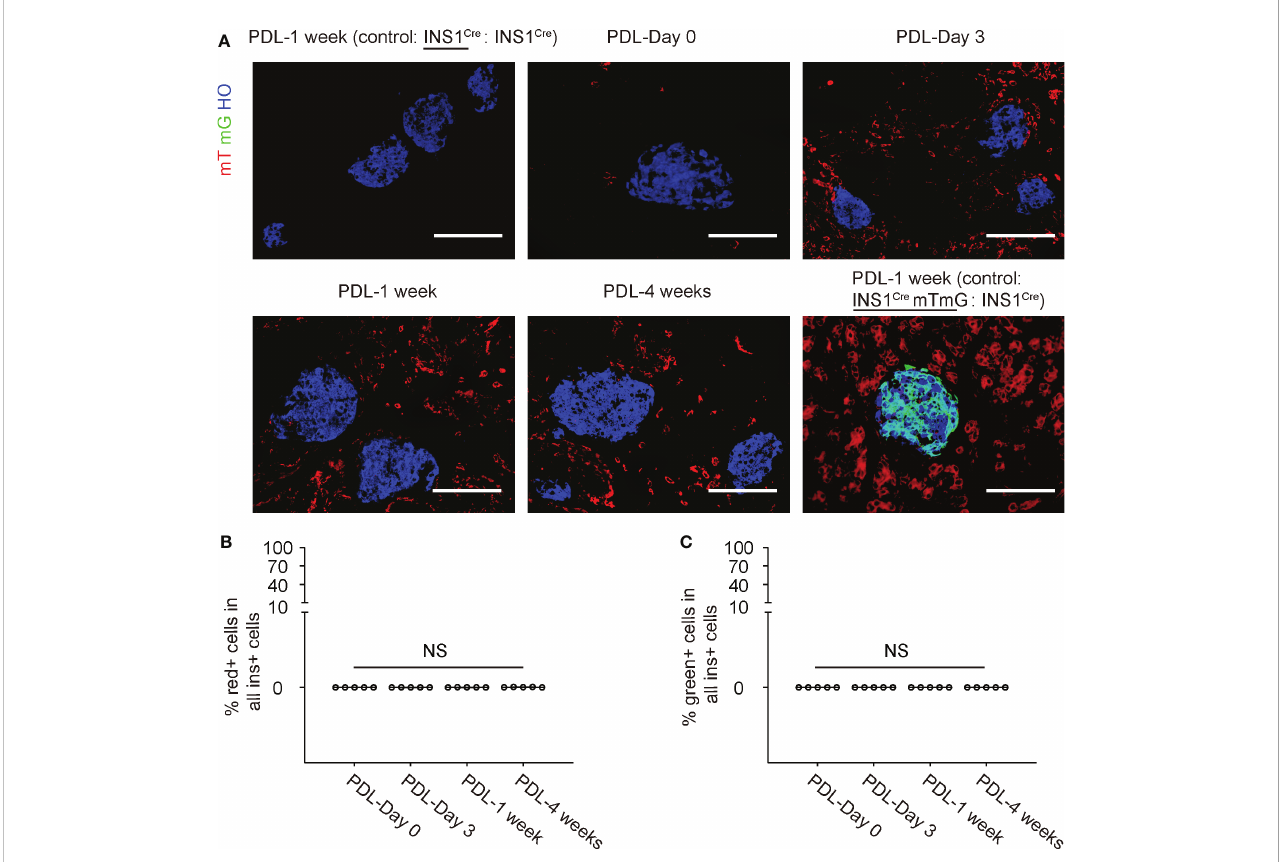
FIGURE 4 No red/green beta-cells are detected in the in fl amed PDL pancreas. (A) Representative immunohistochemical images for mT, mG and insulin. Besides the ligated PDL-tail from the INS1 Cre knock-in mouse at different time points, two controls were shown. The fi rst control was the PDL-tail from a control parabiosis by joining two INS1 Cre knock-in mice together, and one of the mice received PDL at the same time point as the experimental groups. This was the negative control for red fl uorescence. The other control was the PDL-tail from another control parabiosis by joining an INS1 Cre mTmG mouse with an INS1 Cre knock-in mice together, and the INS1 Cre mTmG mouse received PDL at the same time point as the experimental groups. This was the positive control for green fl uorescence to detect cell fusion. (B) Quanti fi cation of the mT red (B) or mG green (C) beta-cells in the in fl amed pancreas at different time points after PDL in INS1 Cre knock-in mice that were joined to the ROSA-mTmG mice by parabiosis. NS: non-signi fi cant. N=5 repeats. Scale bars are 100